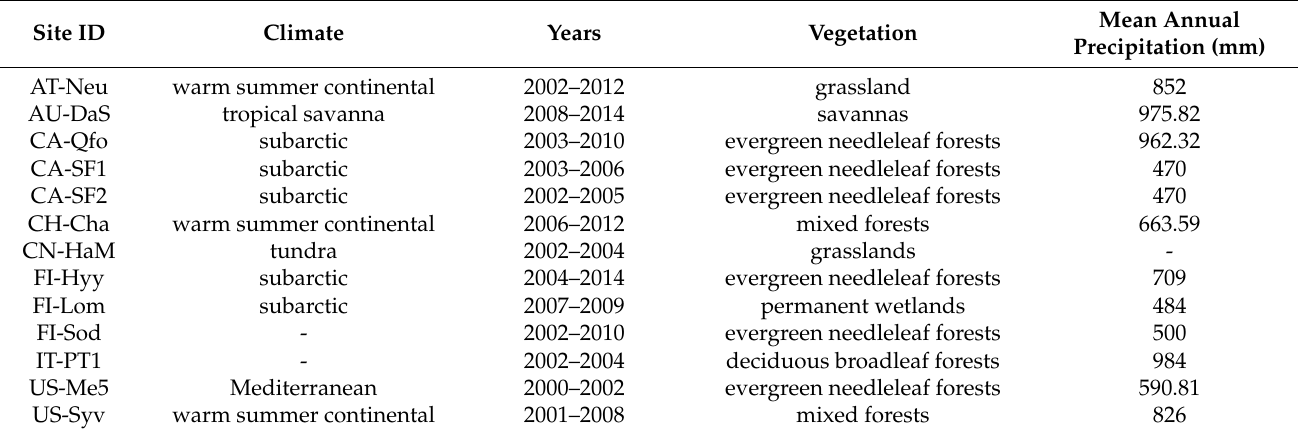
Table 1. Basic information of EC sites used in this study.